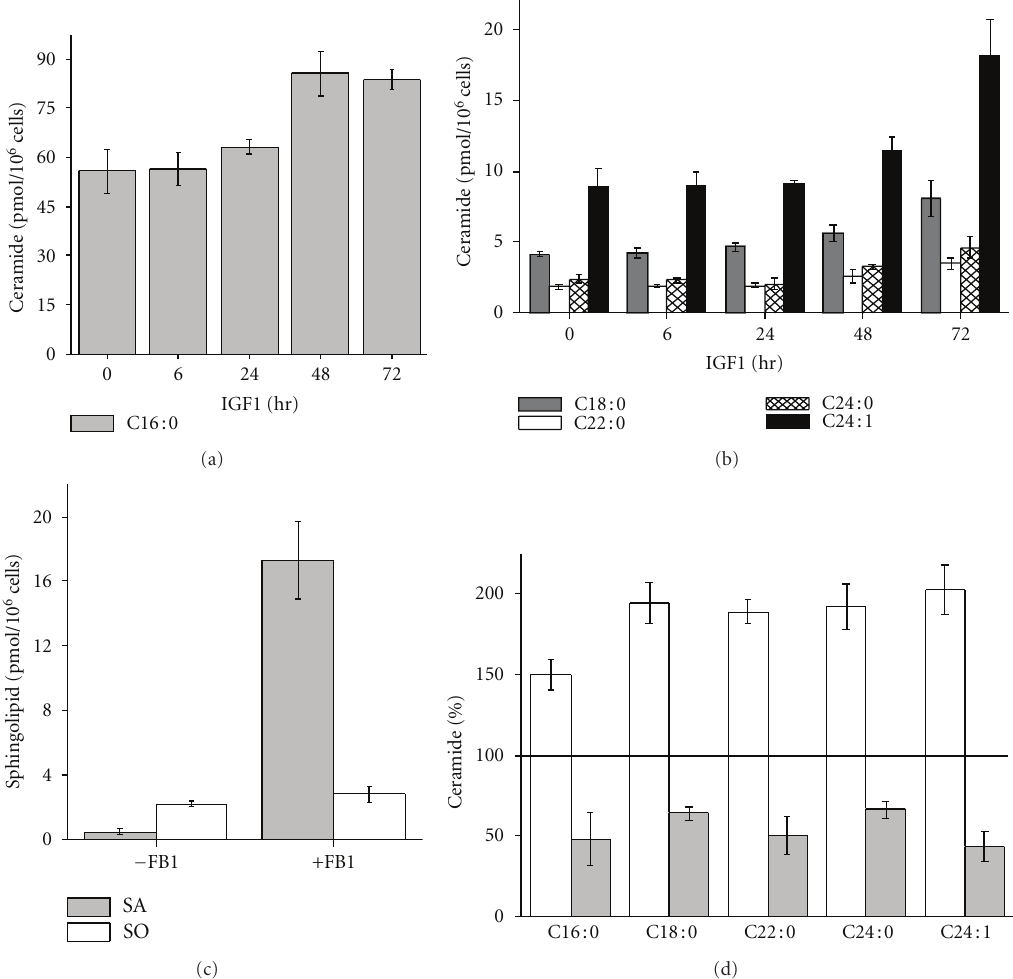
Figure 6: IGF1 increases de novo Cer formation. Levels of (a) C16:0-Cer and (b) C18:0-, C22:0-, C24: 0-, and C24:1-Cer in VH-64 cells incubated for the indicated times with IGF1 (100ng/mL). (c) Levels of sphinganine (SA) and sphingosine (SO) in VH-64 cells treated for 72 hours with IGF1 (100ng/mL) in the absence and presence of FB1 (30 μ M). (d) Percentage of di ff erent Cer species in VH-64 cells treated for 72 hours with IGF1 (100ng/mL) in the absence (white columns) and presence (grey columns) of FB1 (30 μ M). Values of vehicle-treated controls for the di ff erent Cer species were set to 100%. Error bars: mean ± SD of triplicate determinations.